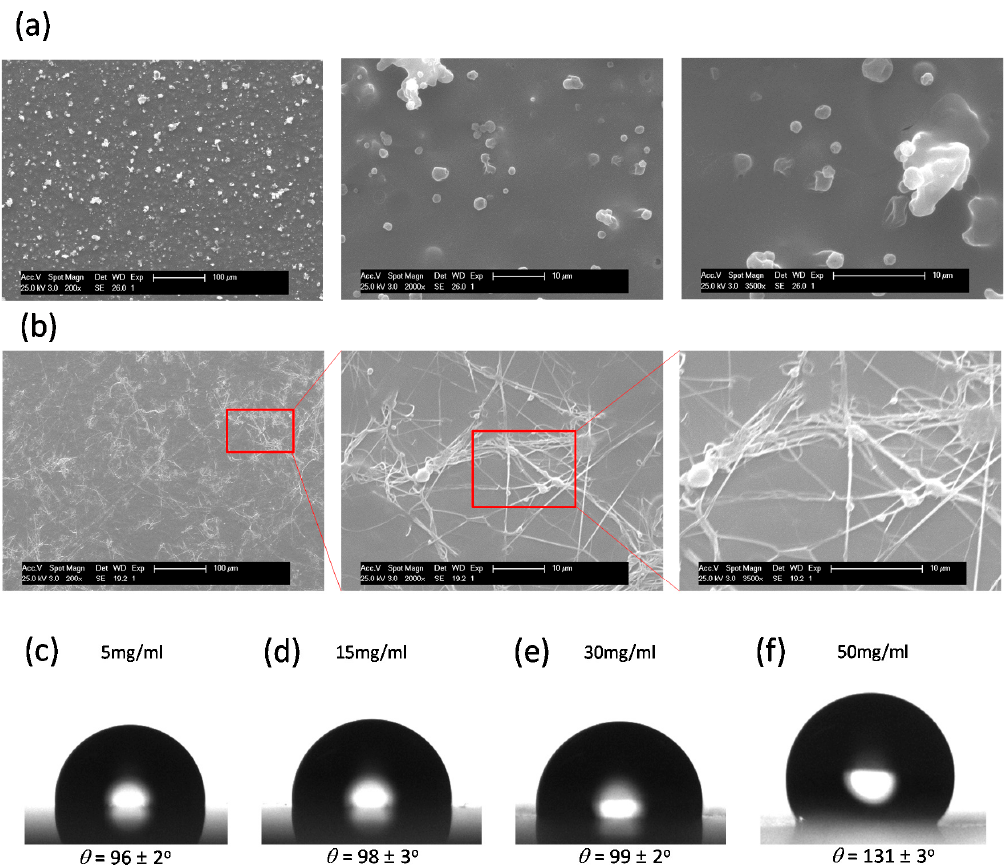
Figure 4. SEM images of the PS 40 ( a ) and PS 250 ( b ) surfaces prepared at a concentration of 50 mg/mL. Contact angle values measured for PS 250 sprayed surfaces using polymer solutions at different concentrations: ( c ) 5 mg/mL; ( d ) 15 mg/mL; ( e ) 30 mg/mL and ( f ) 50 mg/mL. The films were fabricated applying 10 layers.